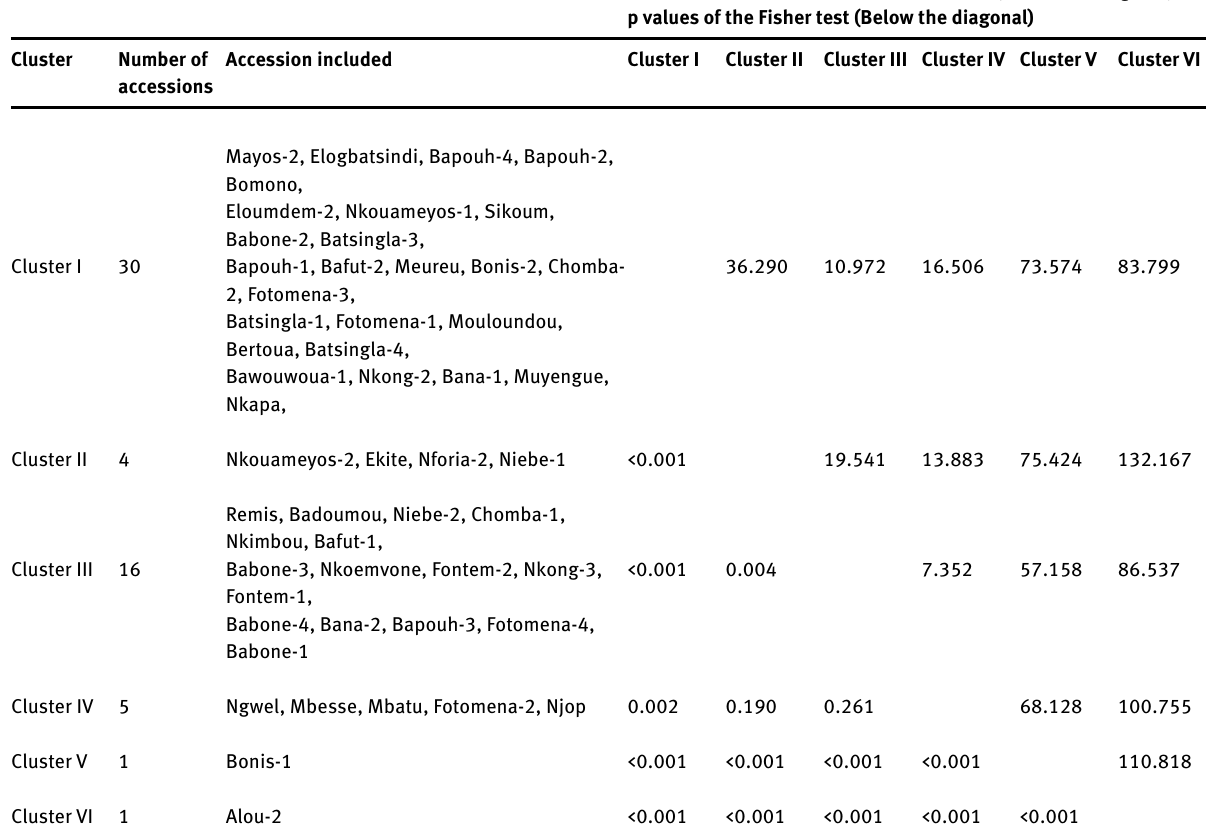
Table 9: Eigenvectors and eigenvalues of the first six principle components for 16 quantitative traits of 57 Dioscorea bulbifera accessions from Cameroon Quantitative trait